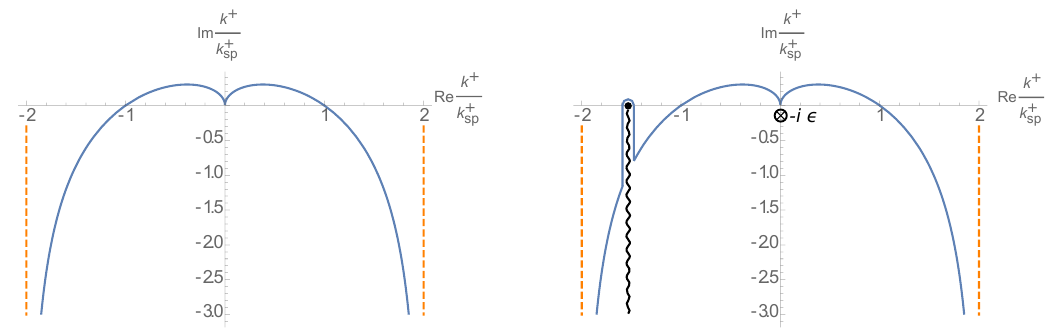
Figure 4 . Left panel shows the steepest descent contour for the k + integral. Vertical dashed lines denote the asymptotics of the steepest descent contour. The right panel shows a sample contour which may result from trying to distort the k + integration contour from going along the real axis to the steepest descent contour (see